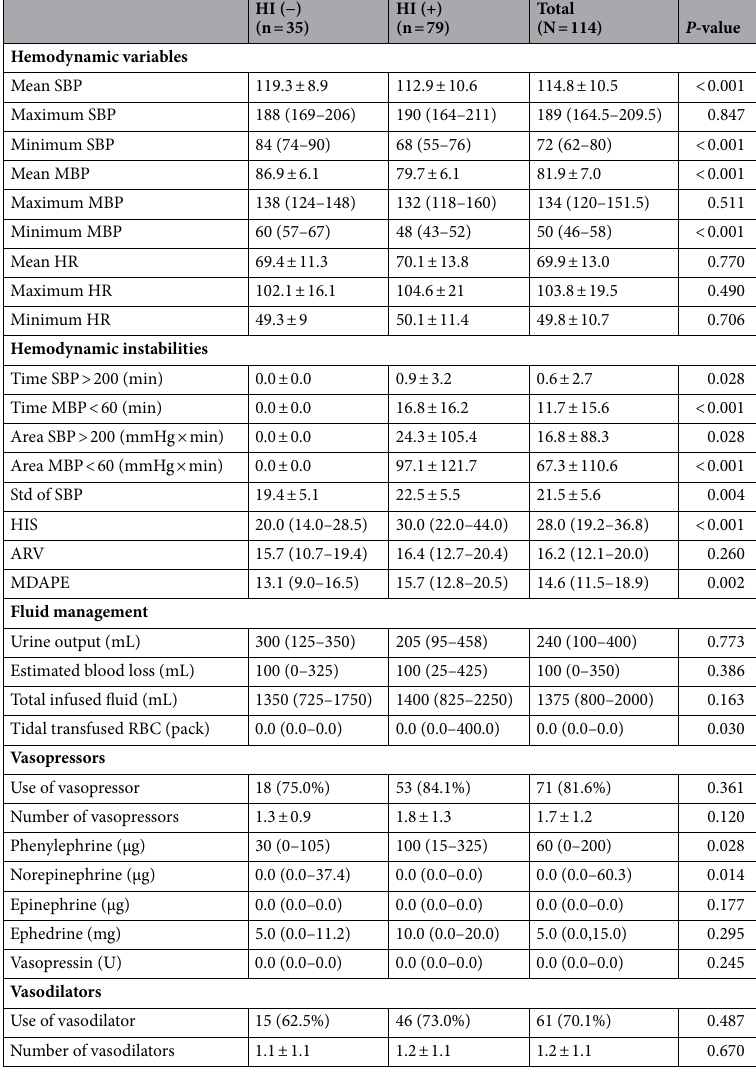
blood pressure; MBP, mean blood pressure; Std, standard deviation; HIS, hemodynamic instability score; ARV, average real variability; MDAPE, median absolute performance